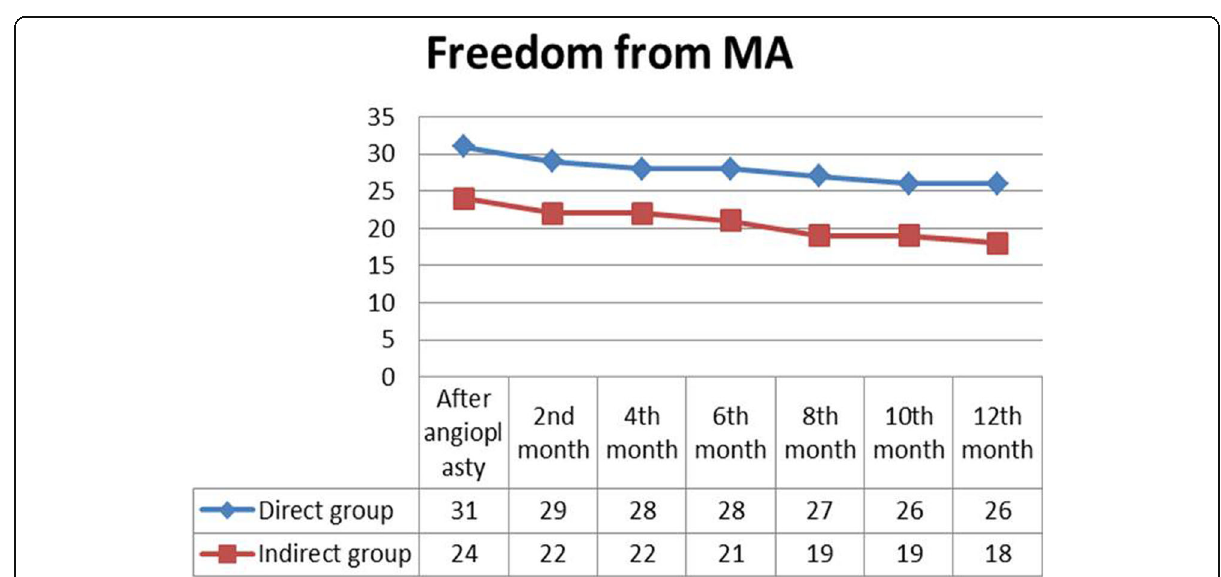
Fig. 3 Curves showing freedom from major amputations between direct and indirect